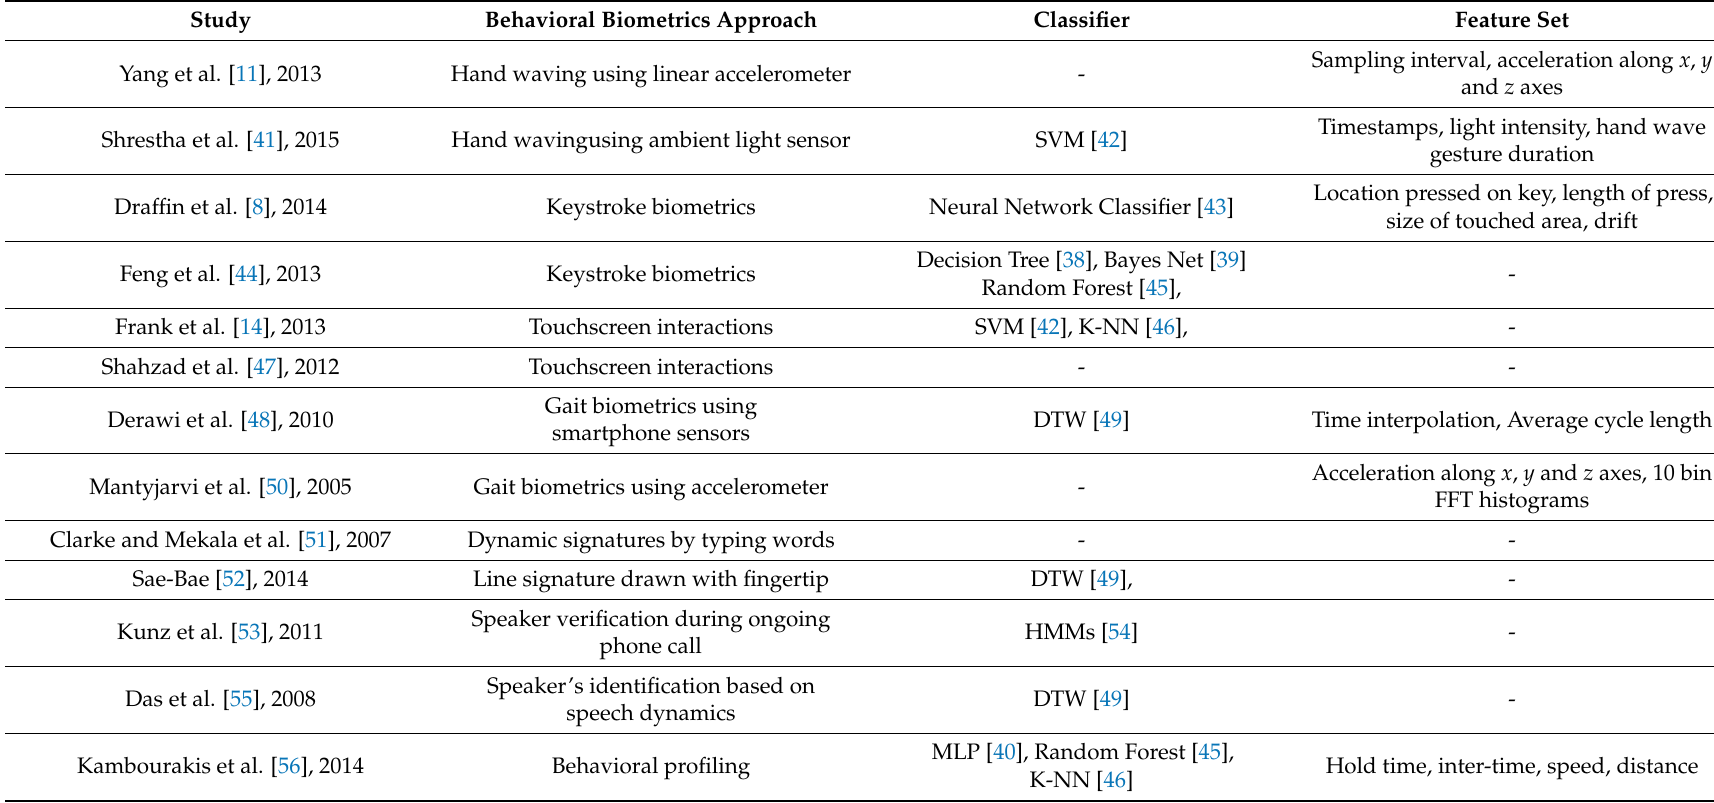
Table 1. A comparison of different studies of behavioral authentication of smartphone